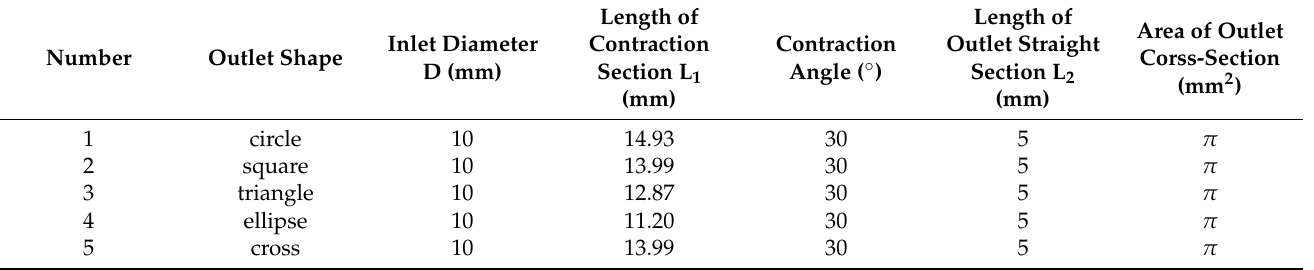
Table 1. Main technical parameters of the water jet testing equipment.